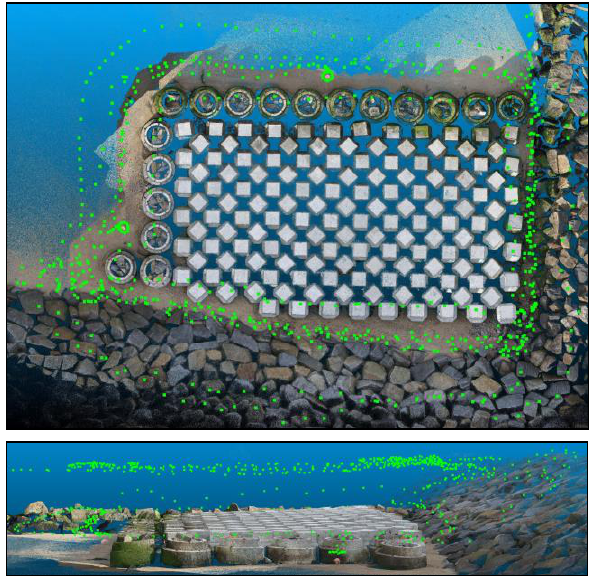
Figure 4. Picture acquisition pattern